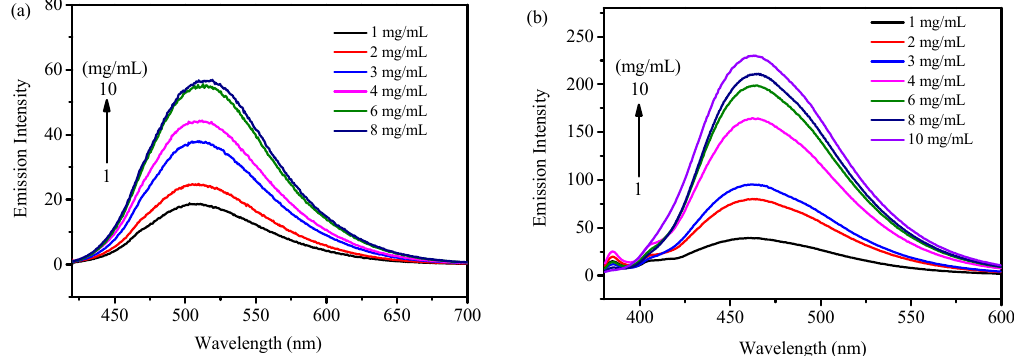
Figure 9. Photoluminescence (PL) spectra in THF at different concentrations ( a ) copolymer before oxidization, excited at 410 nm; ( b ) oxidized copolymer, excited at 370 nm.